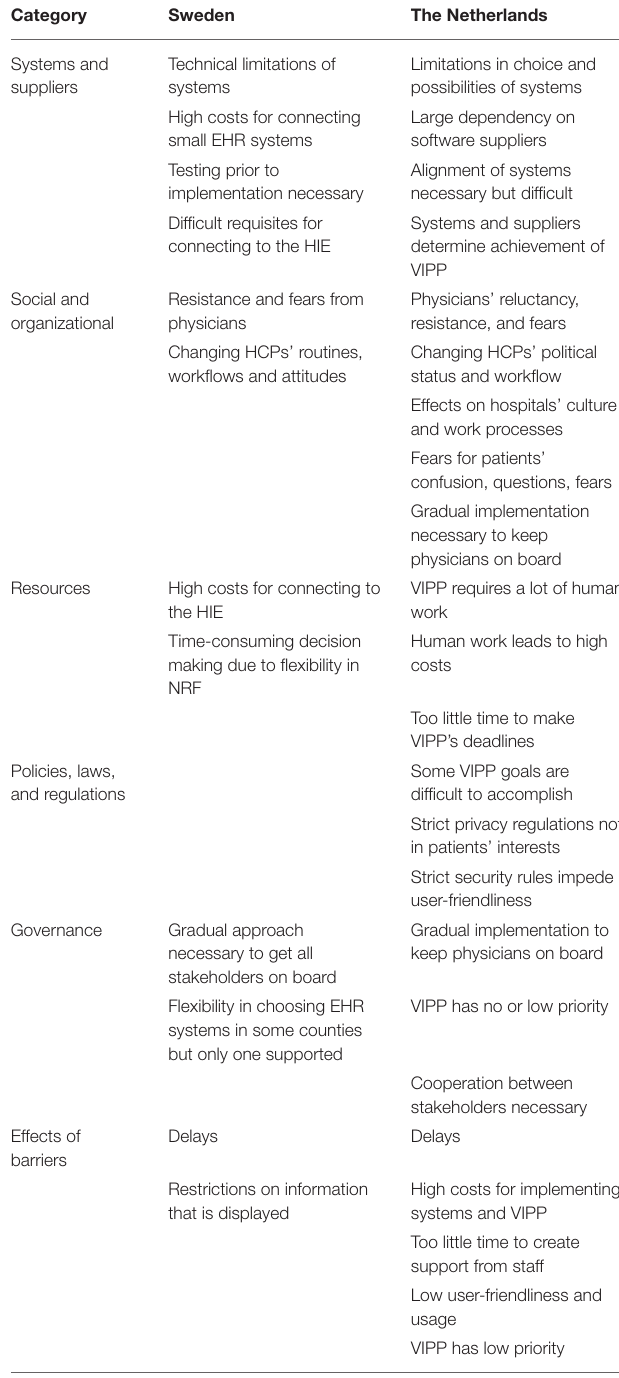
TABLE 4 | Barriers on the local implementation